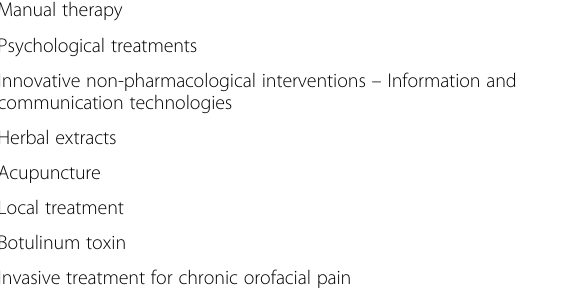
Table 1 Treatments for PHs and other CFP as outlined in the text Manual